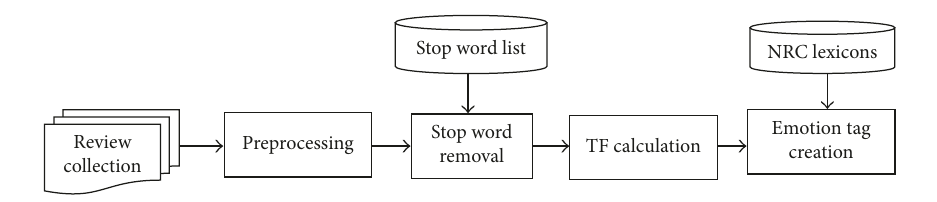
Figure 3: Emotion tag